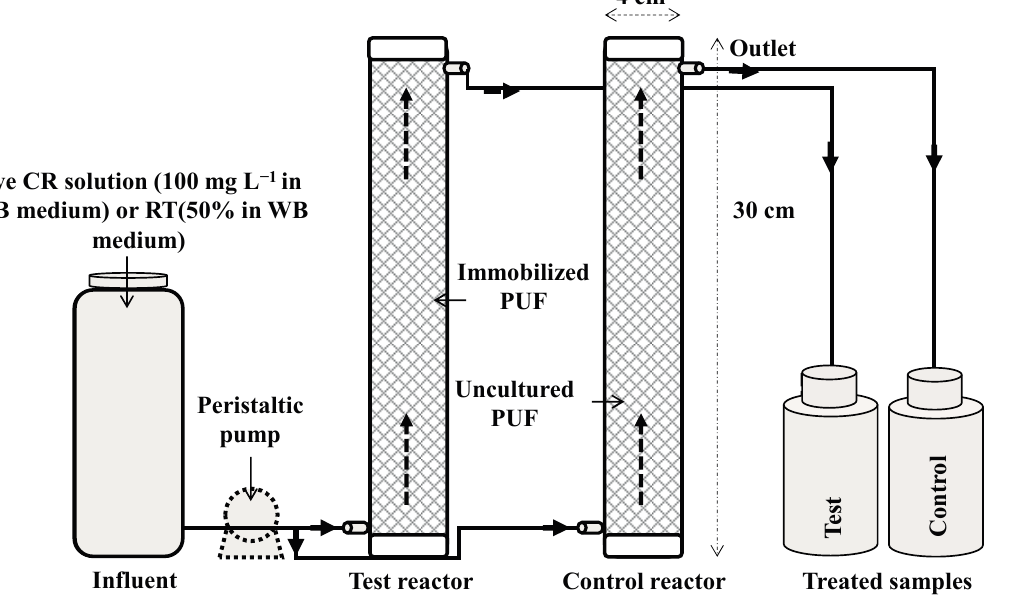
Figure 1. Schematic diagram of the developed upflow column